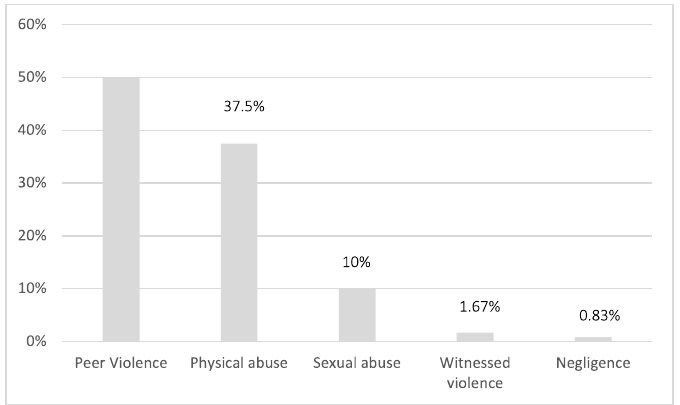
Figure 4. Distribution of cases of mistreatment.